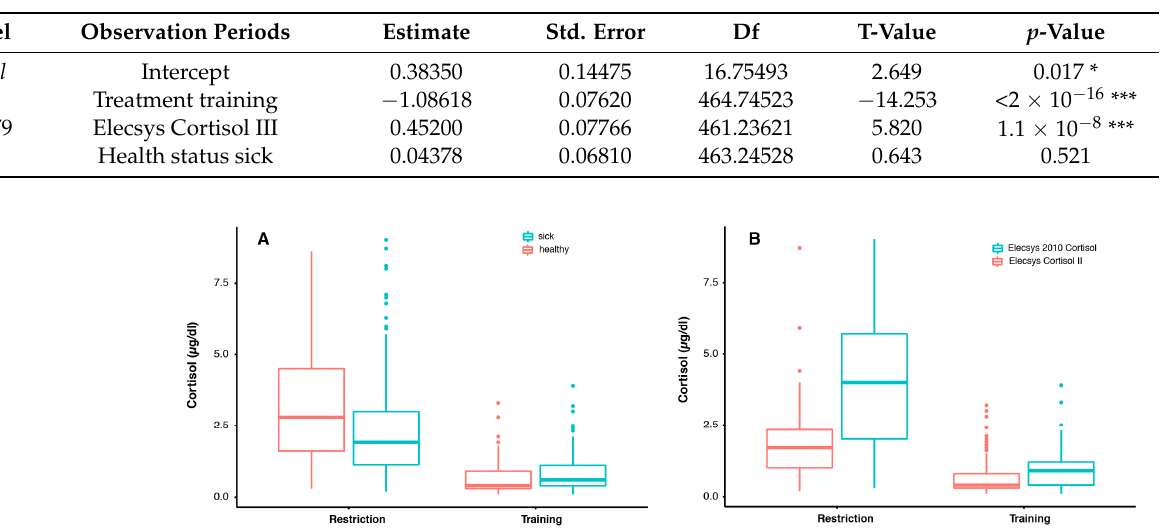
. Figure A2. Blood cortisol values for five female and five male dolphins who underwent two different treatments: restriction and training. ( A ) Healthy animals versus animals experiencing medical treatment (referred to as sick). (B) The two different test assays, which had different sensitivities. Table A2. Tukey’s pairwise post hoc comparisons for feeding experiment I; see Figure 8. Contrast Estimate SE df T Ratio